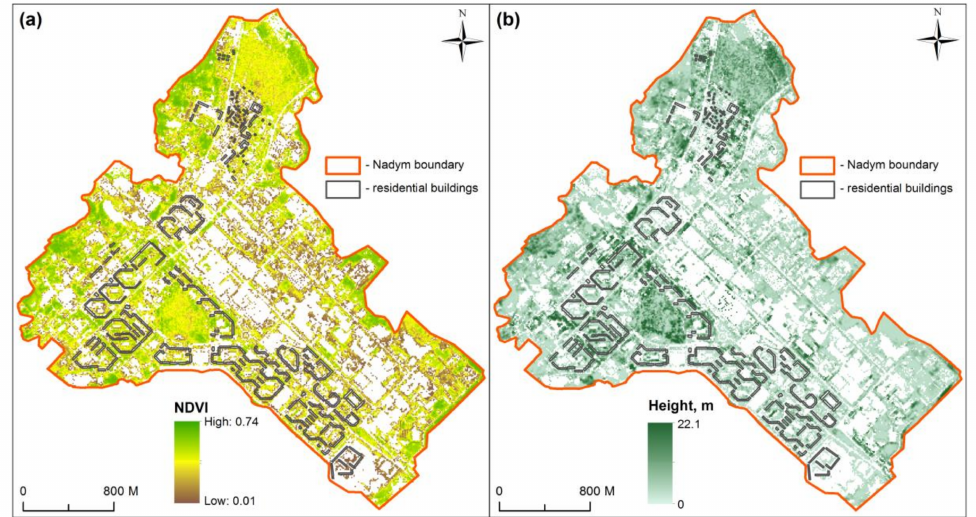
Figure 3. Distribution of the NDVI ( a ) and height values ( b ) across the